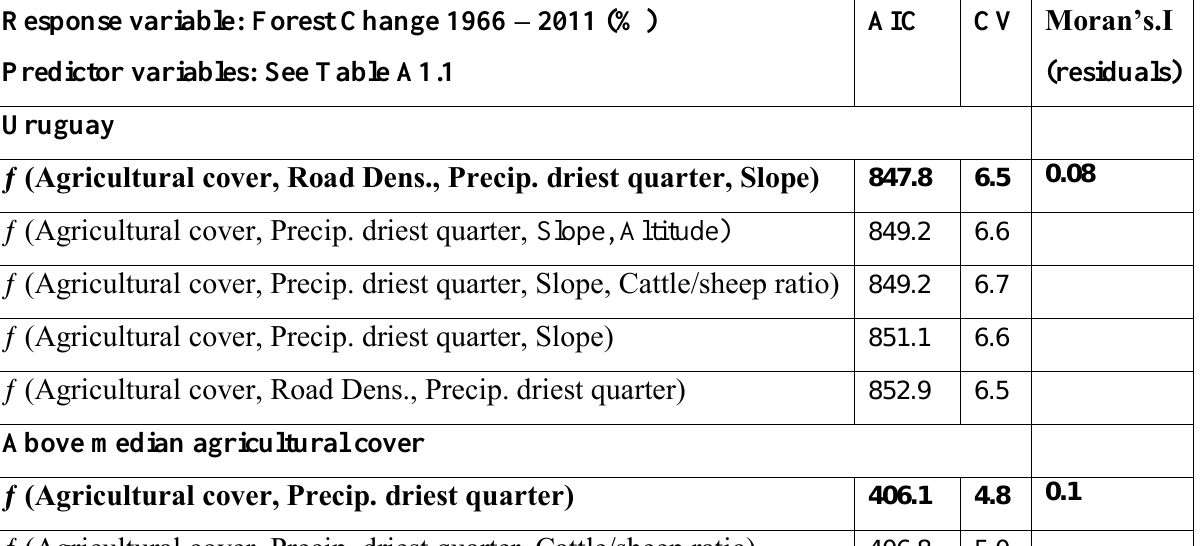
Best models and selection